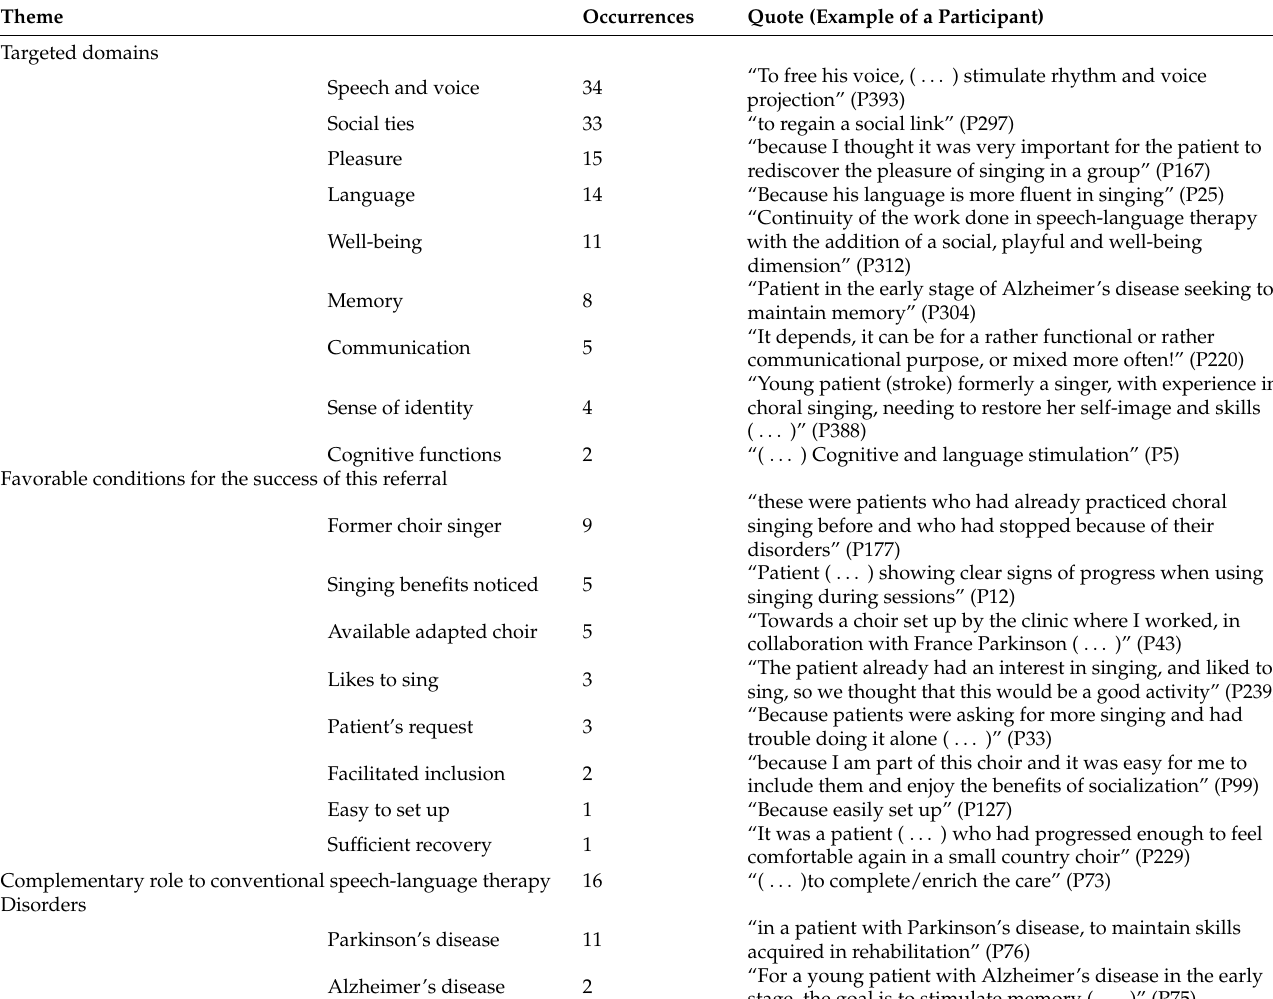
Table 3. Thematic analysis of open-ended responses to question 19: “Could you briefly explain why you referred a patient to a choir?” (89